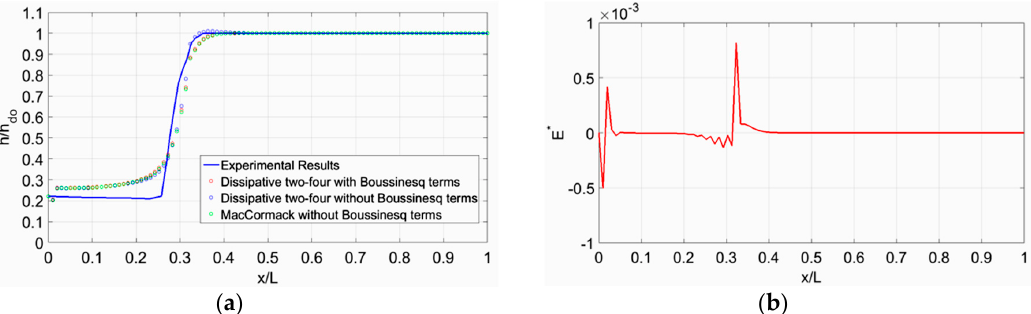
Figure 5. Experimental and Numerical Results for test case 4: ( a ) Free surface profile; ( b ) Boussinesq